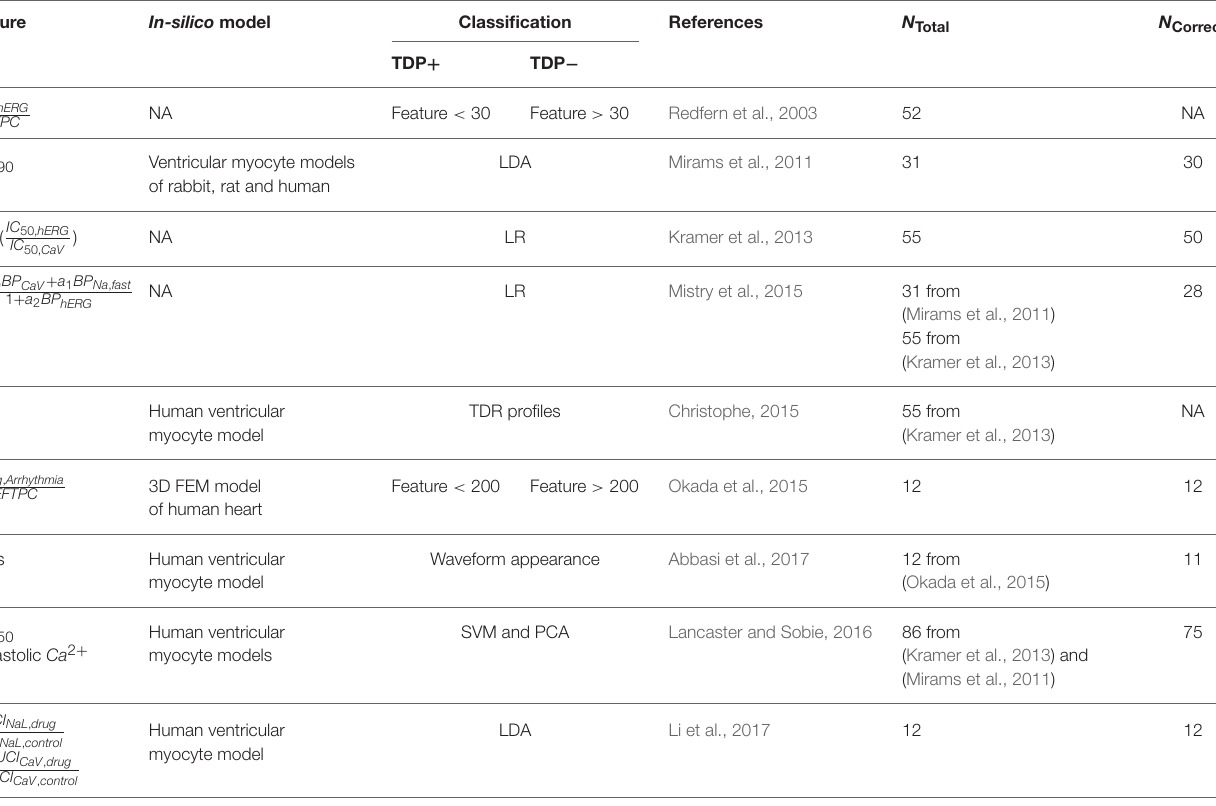
TABLE 1 | TdP classifiers based on in-vitro ion channel